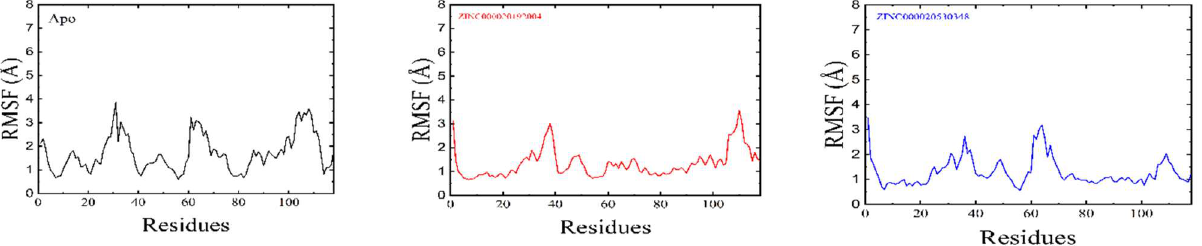
Figure 8. RMSF graphs of the apostate, ZINC000020192004, and ZINC000020530348. The number of residues is shown on the x-axis.